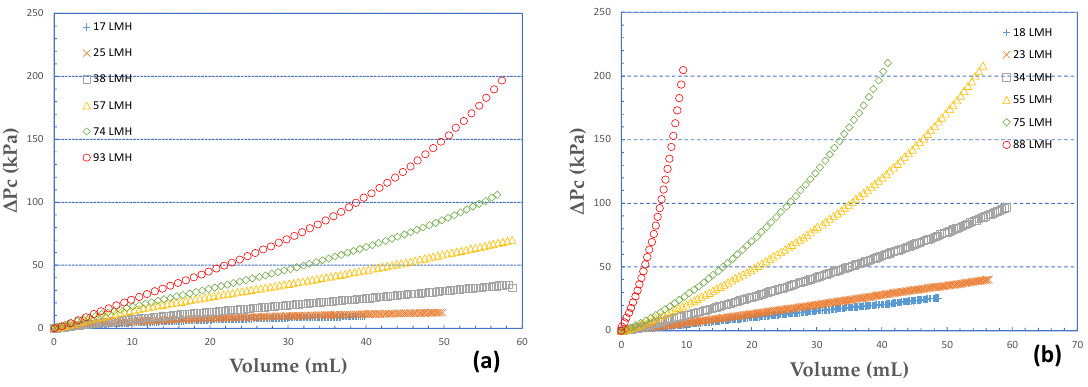
c versus permeate volume. Fouling species: